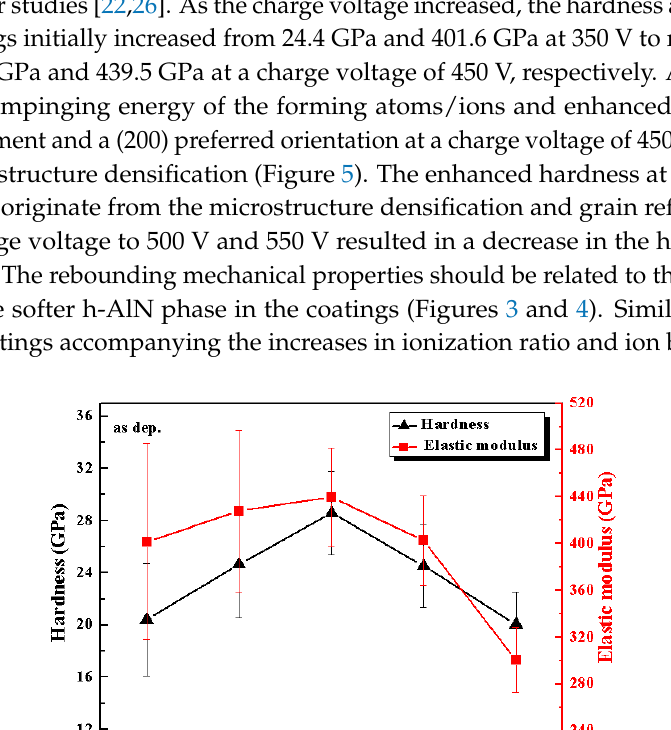
Figure 6. The hardness and elastic modulus of AlCrN coatings deposited at different charge voltages.